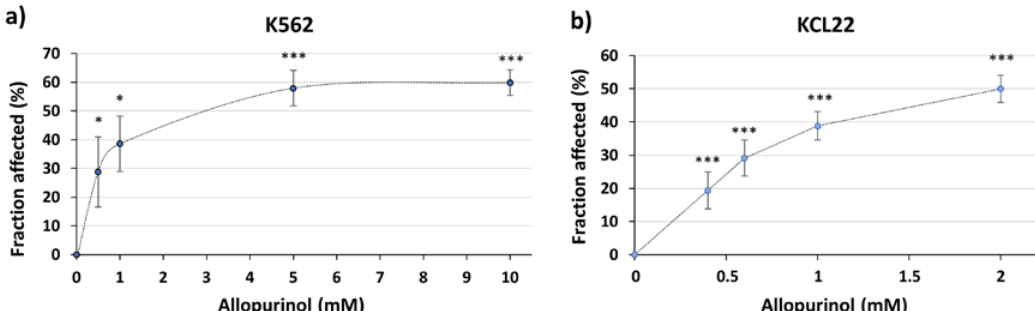
Figure 1. Allopurinol reduces the proliferation of the K562 and KCL22 cells. Cells were treated with different concentrations of allopurinol for 48 h. Proliferation was analyzed by MTT assay. ( a ) Results show the fraction affected or percentage of inhibition with respect to control in K562 cells ( n = 3). ( b ) Fraction affected or percentage of inhibition with respect to control in KCL22 cells ( n = 6). * p < 0.001 and *** p < 0.05 reflect significant differences with respect to control.